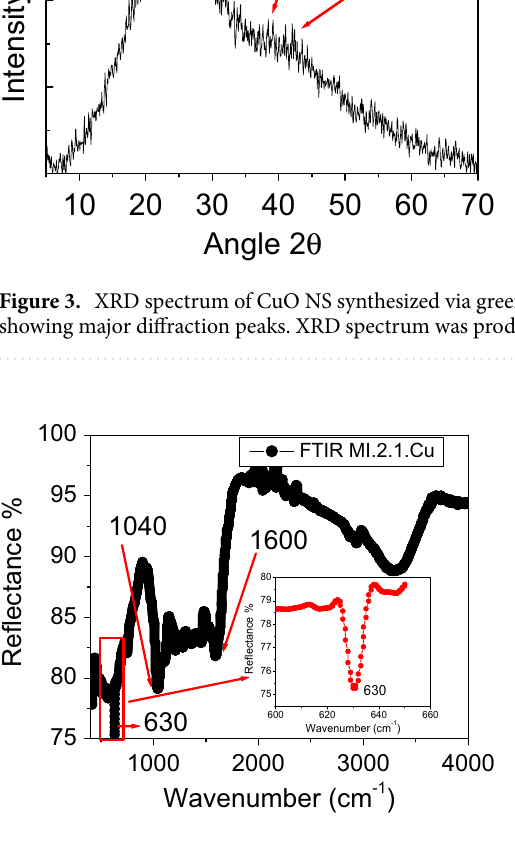
Figure 4. FTIR spectrum showing various absorption bands. The inset magnified part of the spectrum showing clearly the sharp peak at 630 cm −1 corresponding to the formation of pure CuO nanosheets. OriginPro 2018 (64bit) was used to plot